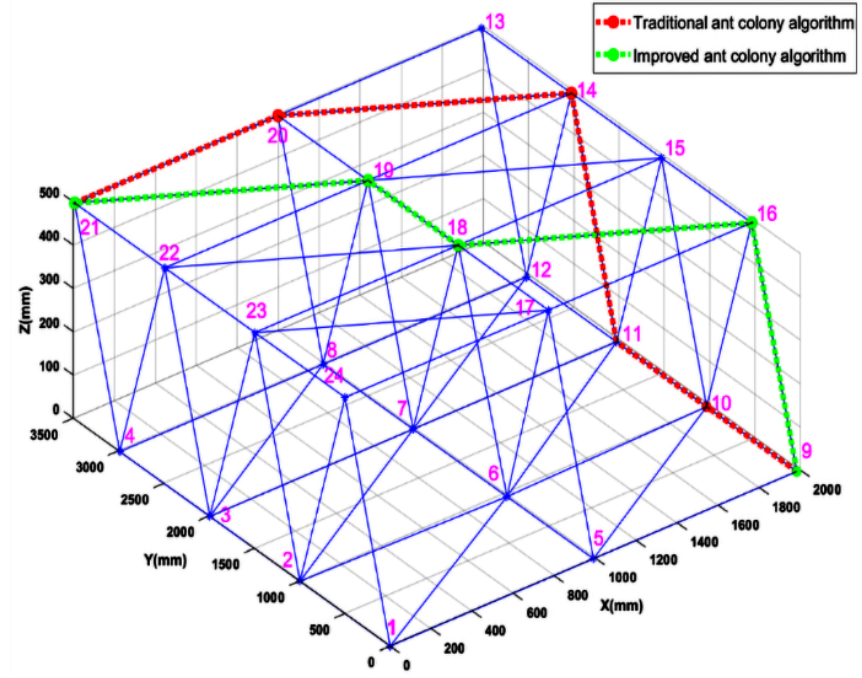
Figure 11. 3D space path comparison chart.